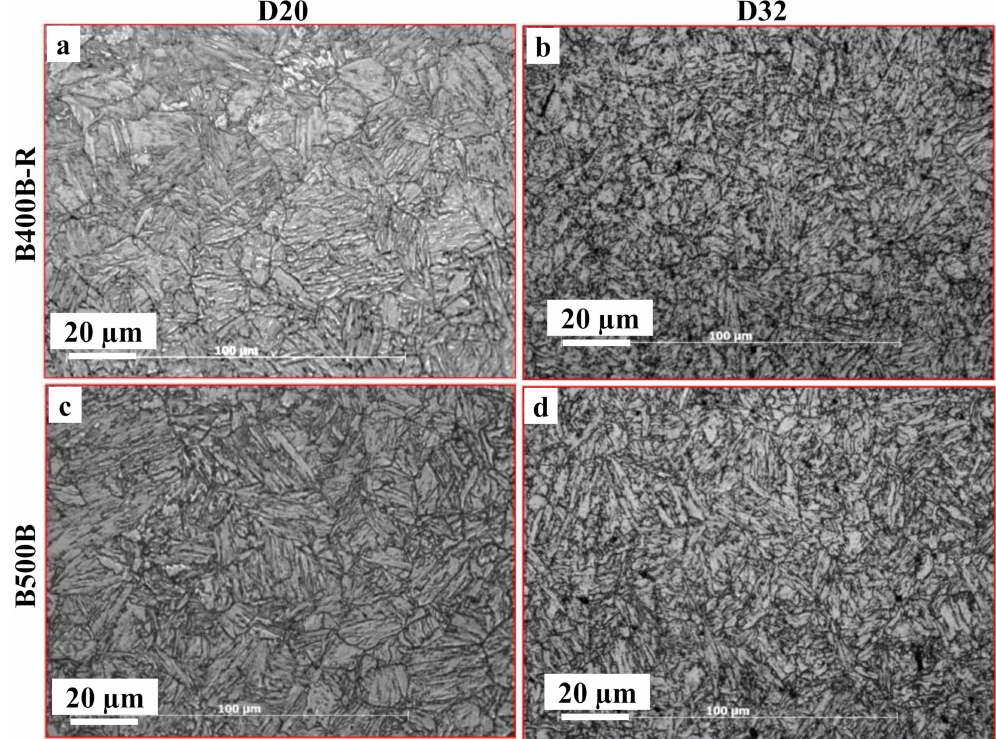
Figure 2. Optical micrographs showing the developed microstructures in the outer surfaces ( a , b ) and ( c , d ) of the D20 and D32 B400B-R and B500B steel grades, respectively.